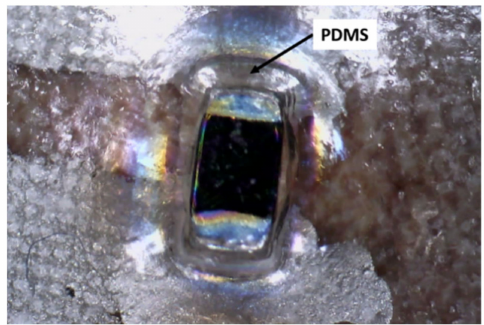
Figure 5. PDMS drop used to isolate the sensor from skin contact.